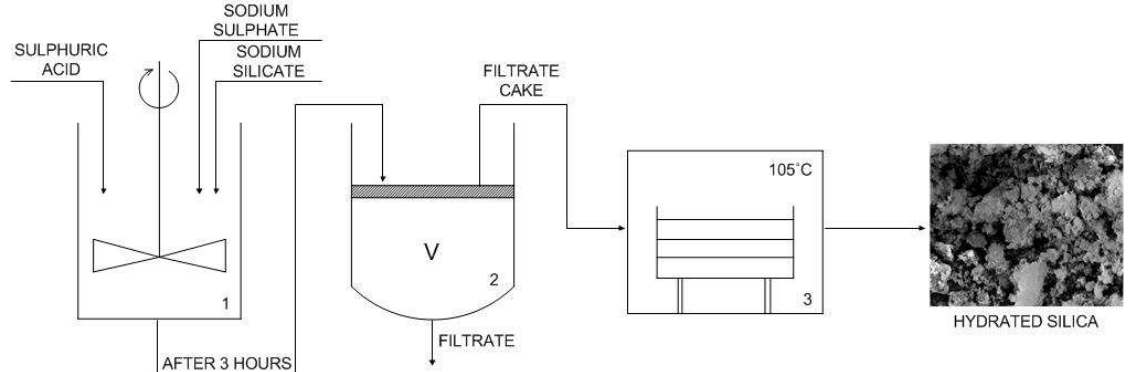
Figure 1. Technological process for the synthesis of hydrated silica precipitated in a polar medium. 1 – reactor, 2 – vacuum filter, 3 – convection